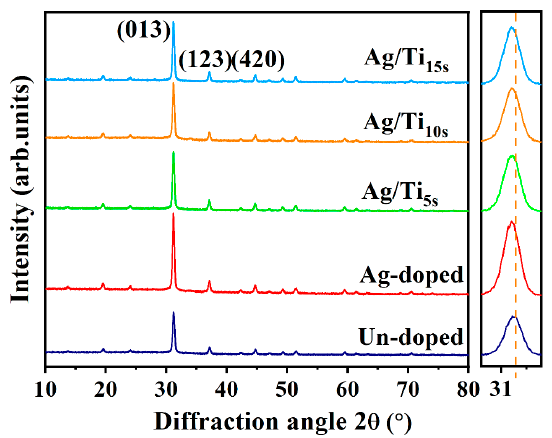
Figure 1. The XRD patterns for Ag/Ti co-doped CoSb 3 , the un-doped and single Ag-doped thin films.